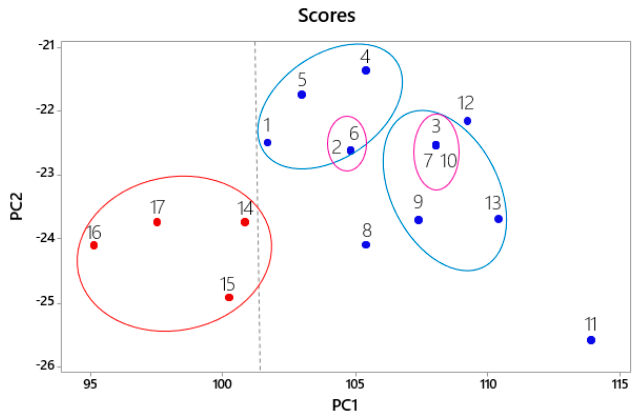
Figure 3. Graphic of the principal components 1 and 2 (PC1–PC2) scores for the most active structures in blue and less active in red.